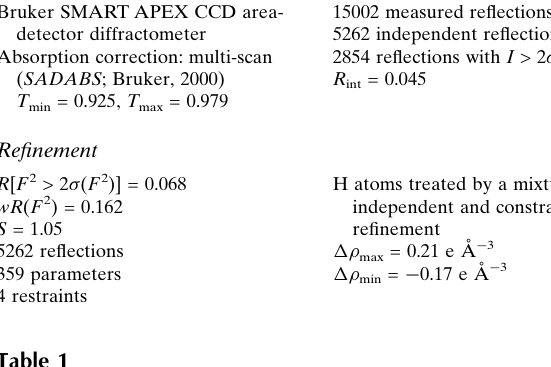
Hydrogen-bond geometry (A˚ , (cid:2)